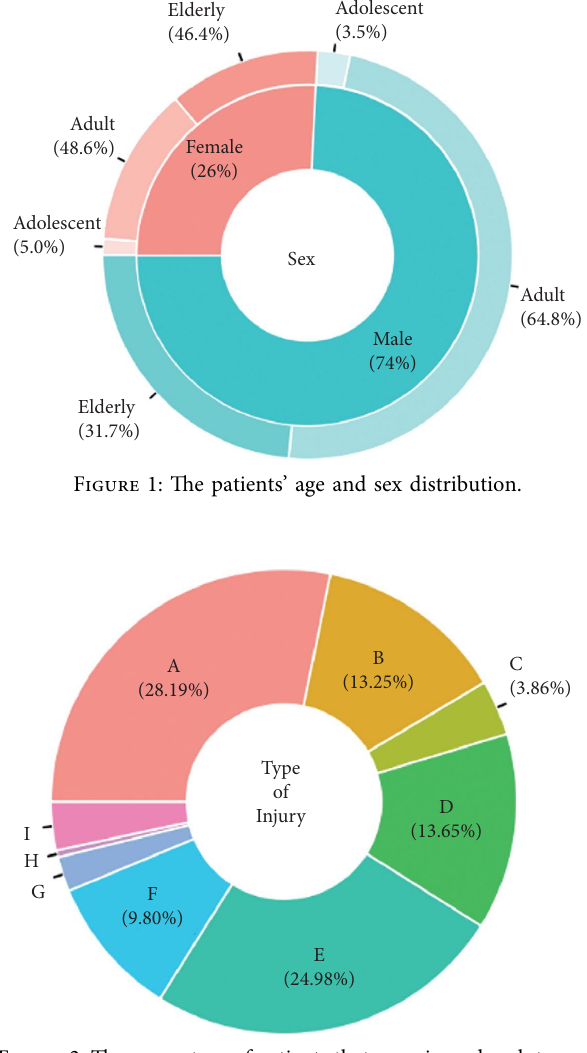
Figure 2: Te percentage of patients that experienced each type of trauma mechanism (A, car accident; B, motorcycle accident; C, bicycle accident; D, pedestrian accident; E, fall; F, slipping and rolling down; G, crush injury; H, assault; I, others).